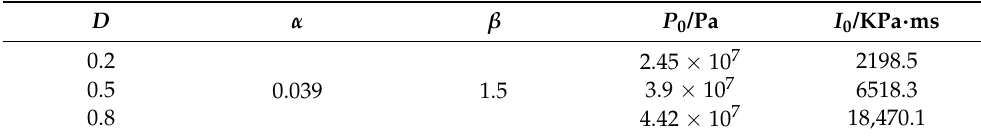
Table 5. Fitted parameter values of P - I curves under geostress